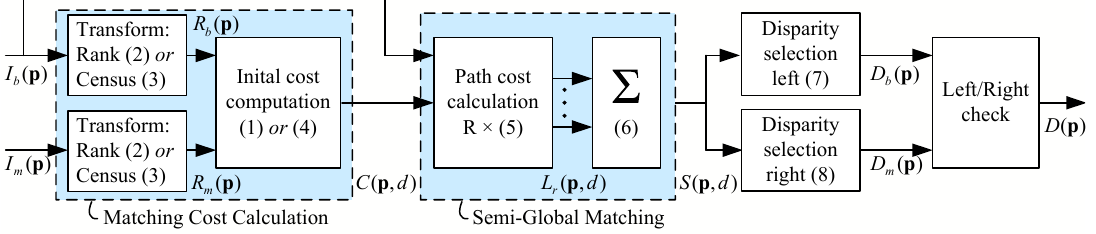
Figure 3: Processing steps for disparity estimation using rank transform/census transform and semi-global